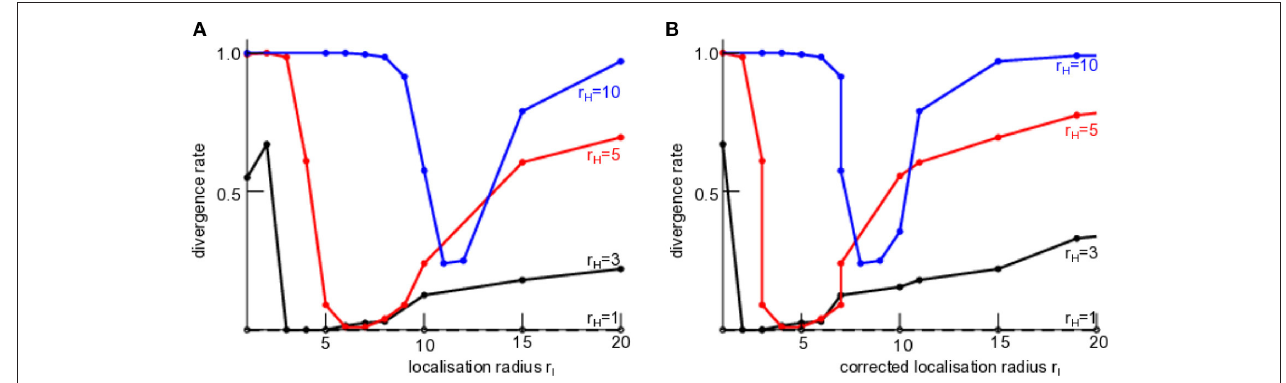
FIGURE 4 | Stability of the LETKF of nonlocal observations dependent on the sensitivity function width r H and the localization radius r l . The divergence rate γ is defined in section 2.8. (A) With original localization radius r l . (B) With corrected localization radius r c and GC low 0 but the chosen observation error is assumed to R R t =